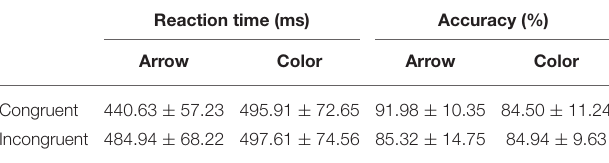
Conflict (Inc., Con.)